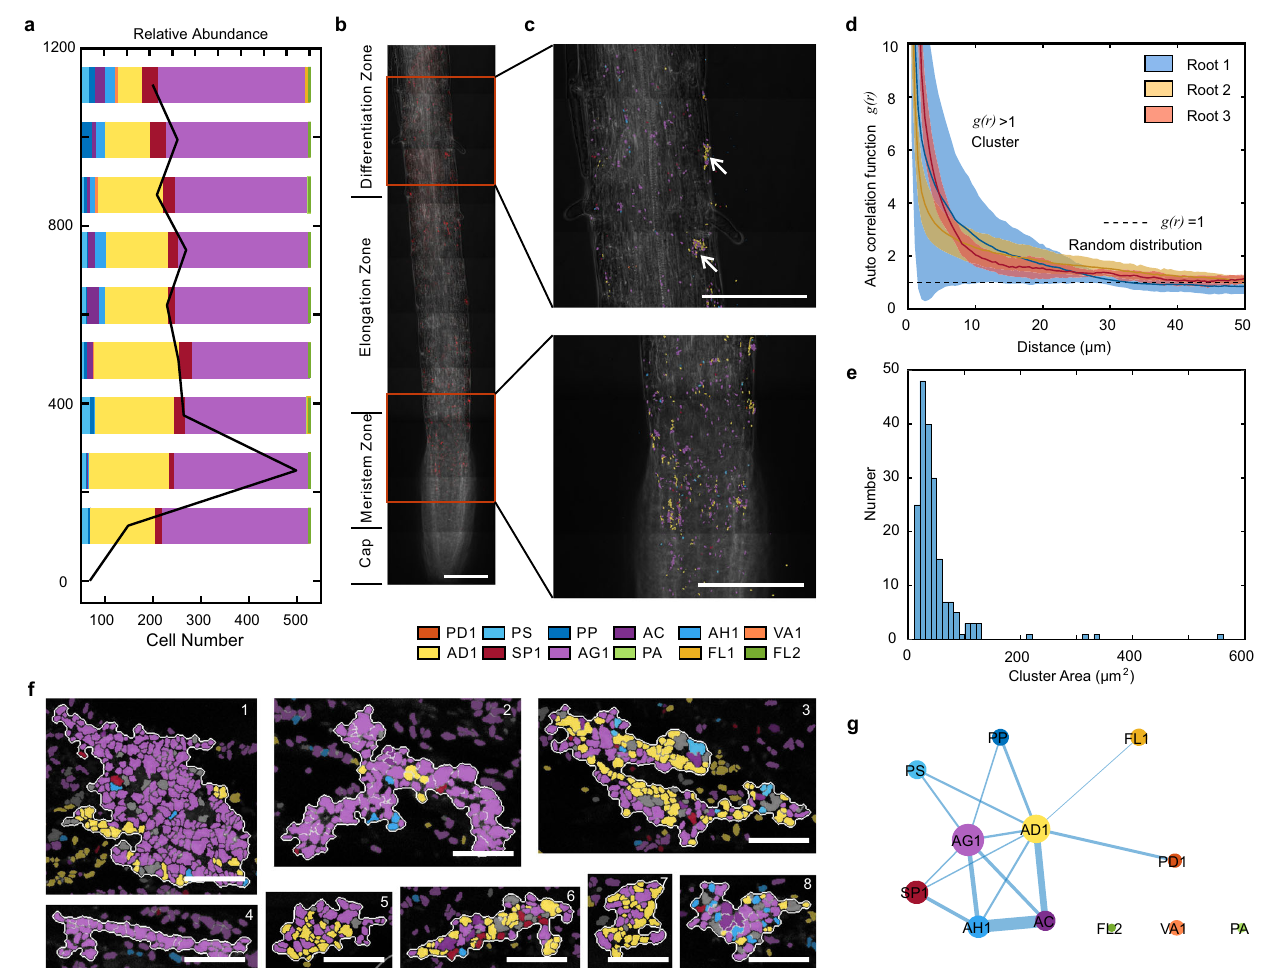
Fig. 5 | Spatial patterns of the root-colonized microbial communities at single cellresolution.a Relativeabundanceofeachspecies(bars)andthenumberofcells (blackline)byimagingalongtherootof Arabidopsis .Eachbarindicatestherelative abundanceinanFOVof125 μ m(width)×250 μ m(length). b Representativeimages illustrate the spatial distribution near the root tip (~1mm from the tip) labeled by the universalprobe EUB338. Scalebar, 100 μ m. c Bacterialcolonizationmarked by the pseudo color of each species at different regions along the root. Species AG1 and AD1 are found in clusters (white arrows). Scale bar, 100 μ m. d The spatial correlation of root-colonized bacterial cells is analyzed by linear dipole algorithm (seeContactfrequencyanalysisinMethods).Thesolidlinesindicatethemeanauto correlation between bacterial cells, the shadows indicate the 95% con fi dence